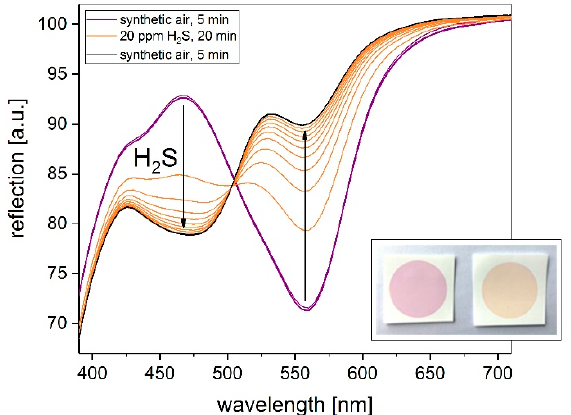
Figure 4. Reflection spectra of the Cu-PAN layer on coated paper reacting to 20 ppm H 2 S in synthetic air and a relative humidity of 40% at room temperature. Recording of 15 measurement cycles with a time lag of 2 min, respectively.